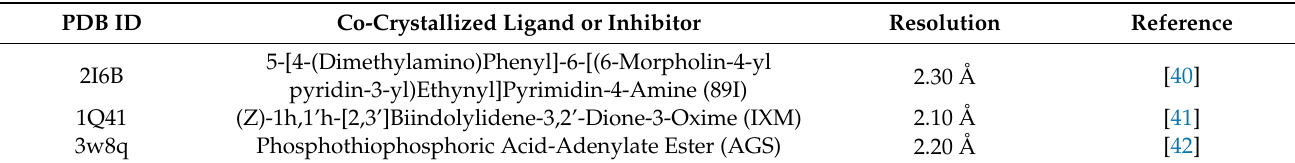
Table 6. Protein acquisition